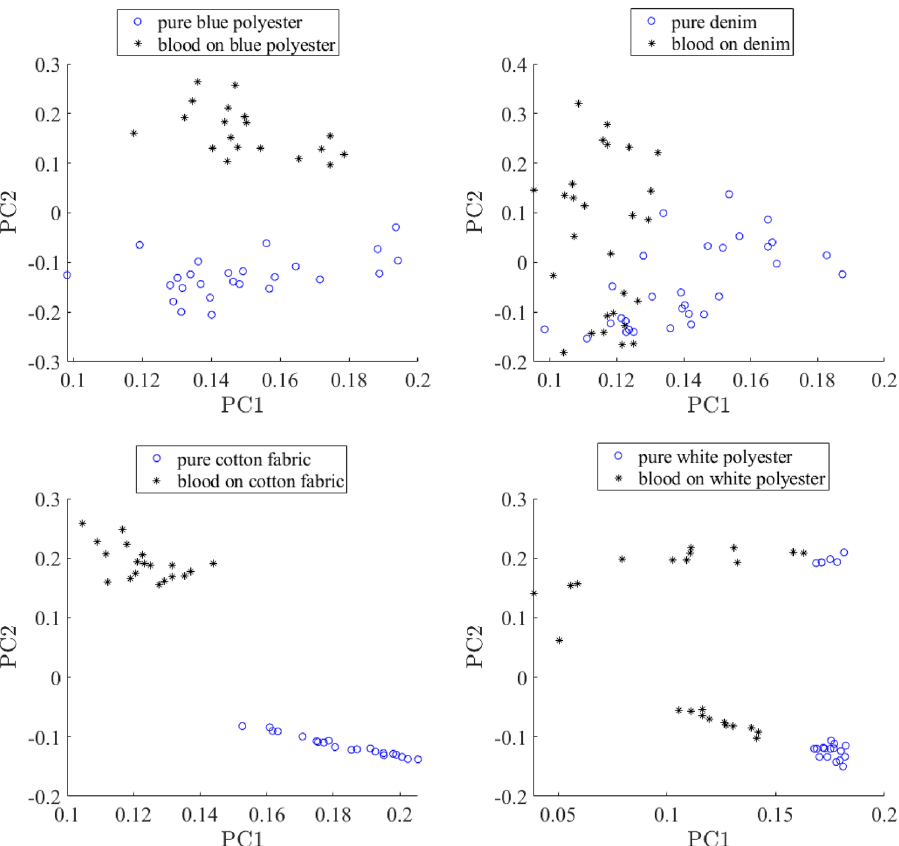
Figure 11. A hierarchical approach to test for potential false positives. Raman spectral data obtained for an apparent bloodstain are statistically compared with Raman spectra obtained for a pure substrate material. Principal component analysis (PCA) score plots prepared using the first and second principal components demonstrate significant separation of the two classes of Raman spectra for blood stains on all substrates